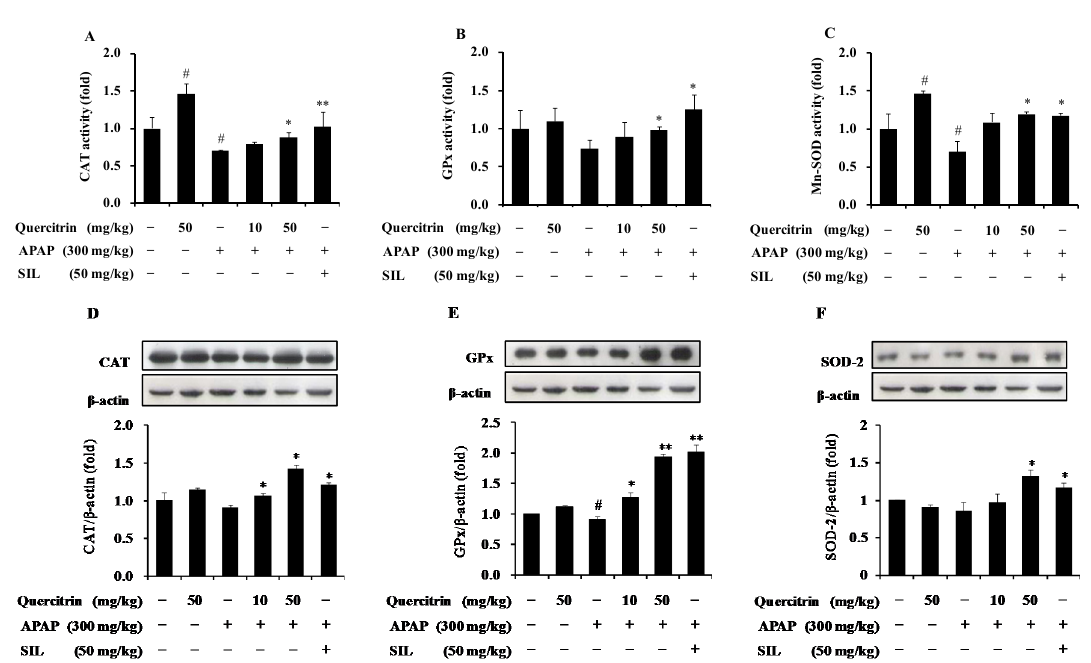
Figure 5. Effects of quercitrin on activities and protein expressions of hepatic antioxidant enzymes in APAP intoxicated mice. The hepatic activities of CAT ( A ); GPx ( B ) and SOD-2 ( C ) were measured as described in Materials and Methods section. The protein levels of CAT ( D ); GPx ( E ) and SOD-2 ( F ) were determined using Western blot analysis. Protein expression levels were normalized with β -actin. All data represent means ± SD of five mice in each group. Significant differences were ( # ) p < 0.05 as compared with the control; (**) p < 0.01 or (*) p < 0.05 as compared with APAP group.